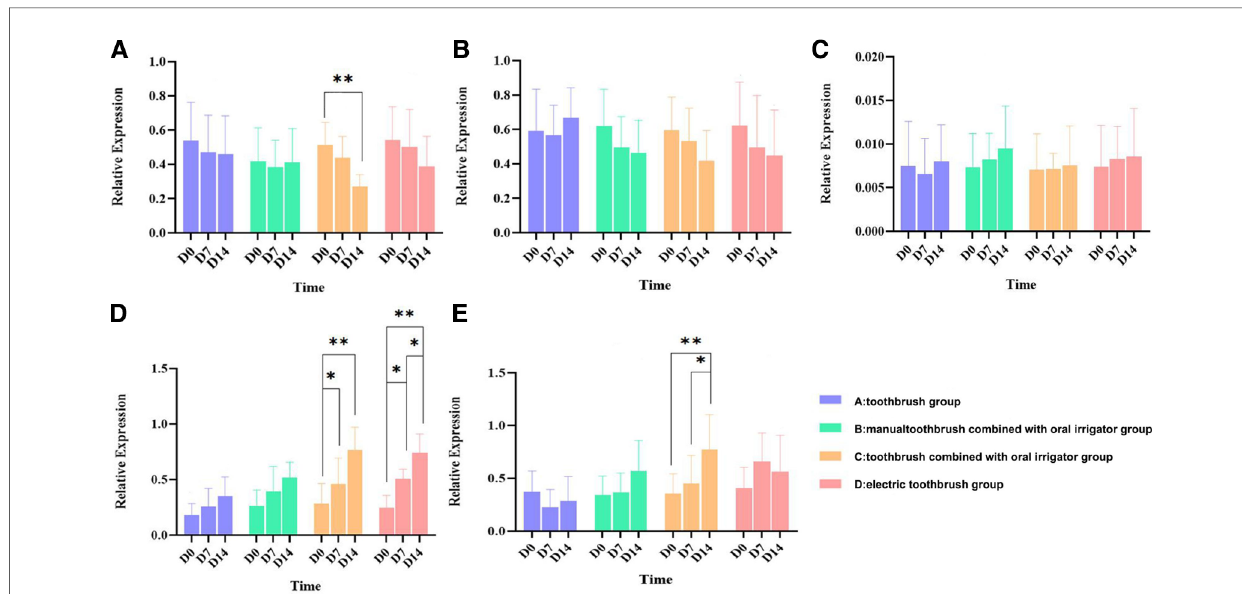
FIGURE 4 Bar chart of relative expression of bacteria in dental plaque. The test data of the sample accord with the normal distribution. * P <0.05, the difference was statistically signi fi cant; ** P <0.01, the difference was statistically signi fi cant. ( A ) Streptococcus mutans; ( B ) oral streptococcus; ( C ) Lactobacillus; ( D ) Actinomyces odontolyticus; and ( E ) Actinomyces